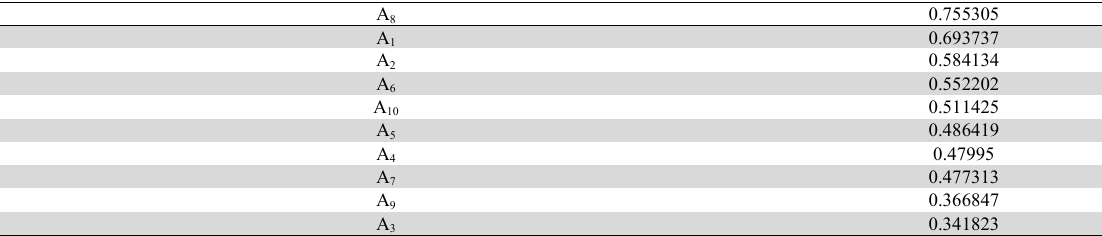
Final sorted relative closeness values